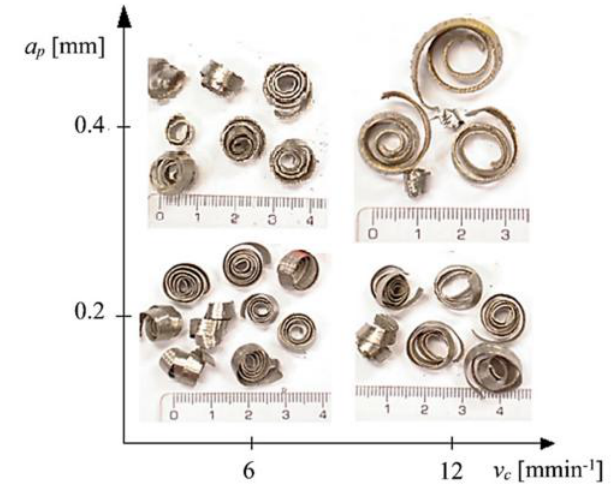
Figure 6. The shapes of chips and their dependence on cutting speed v c and cutting depth a p at tool angles for γ o = 16 ◦ , λ s = 0 ◦ , κ r = 0 ◦